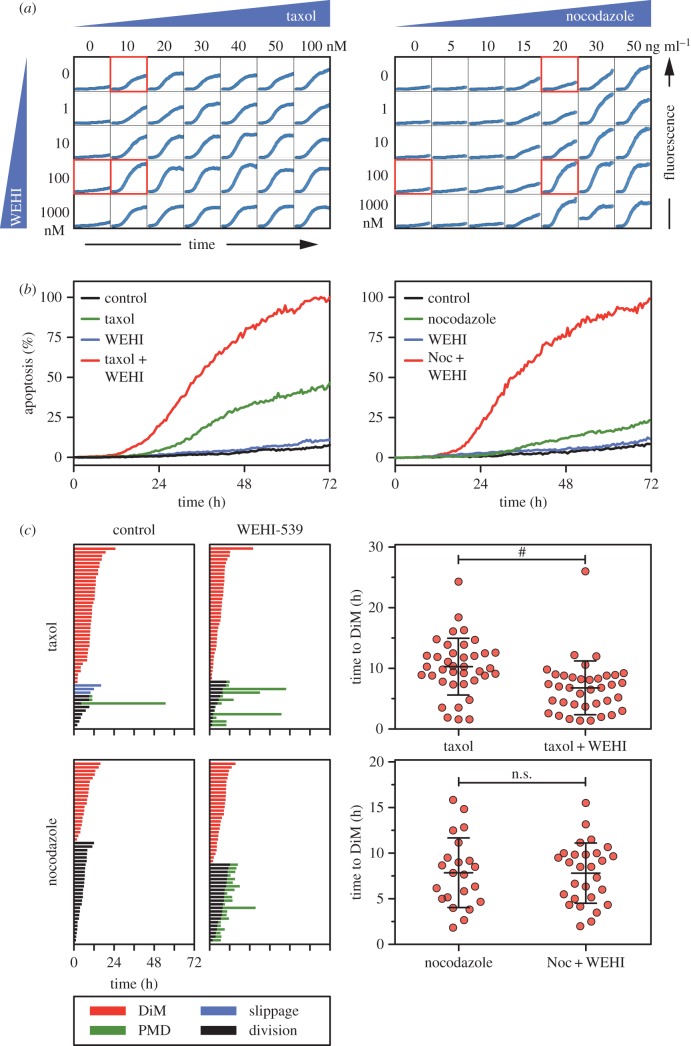
WEHI-539 sensitizes cells to microtubule-binding agents. (a) Concentration matrices showing apoptosis induction over a 72 h time course following exposure of RKO cells to either taxol or nocodazole and WEHI-539. (b) Line graphs showing apoptosis induction following exposure to 10 nM taxol or 20 ng ml−1 nocodazole (Noc) plus 100 nM WEHI-539. (c) Cell fate profiles of cells as treated in (b). For those cells undergoing death in mitosis, the scatter plots quantitate the time from mitotic entry to cell death. #p < 0.0001. Zero hours on the fate profiles represents when cells entered mitosis.